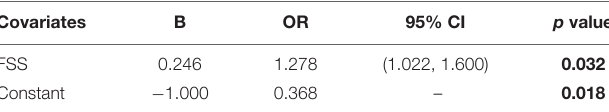
TABLE 4 | Factors associated with the intensity of pain in the multiple linear regression